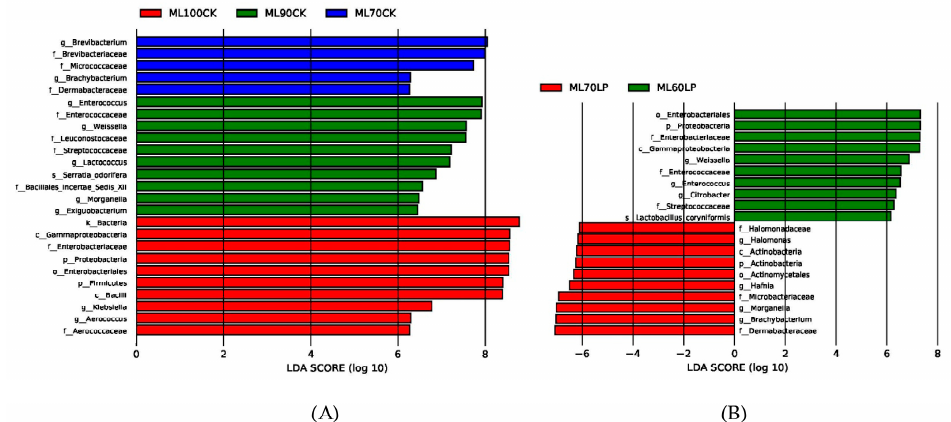
Figure 5. Comparison of microbial variations using LEfSe analysis in non-inoculated ( A ) and inoc- ulated silage ( B ). CK, silage without inoculation; LP, silage inoculated with L. plantarum A345. The numbers after “ML” indicate the proportion of mulberry leaves in silage.